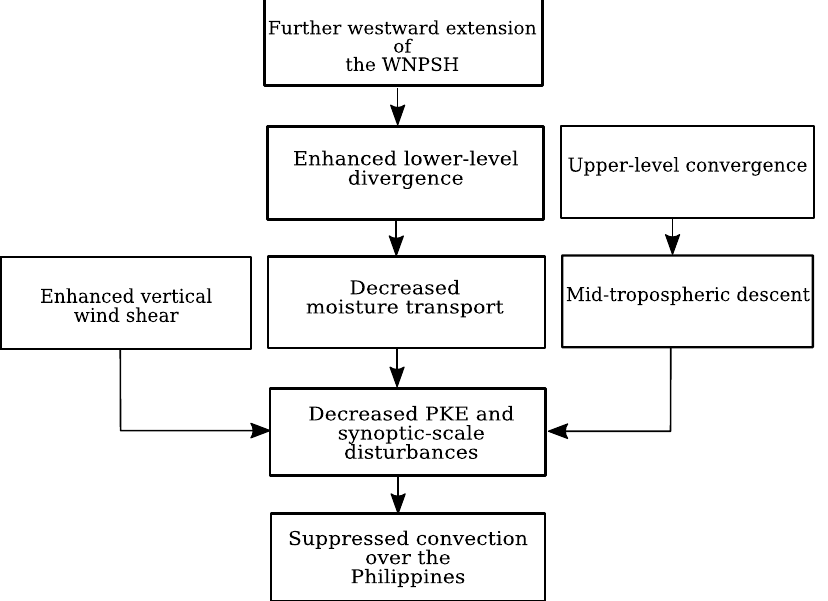
Figure 10. Schematic diagram showing the possible mechanism leading to the decrease in rainfall over the Philippines from early August to early September occurring in the mid-1990s